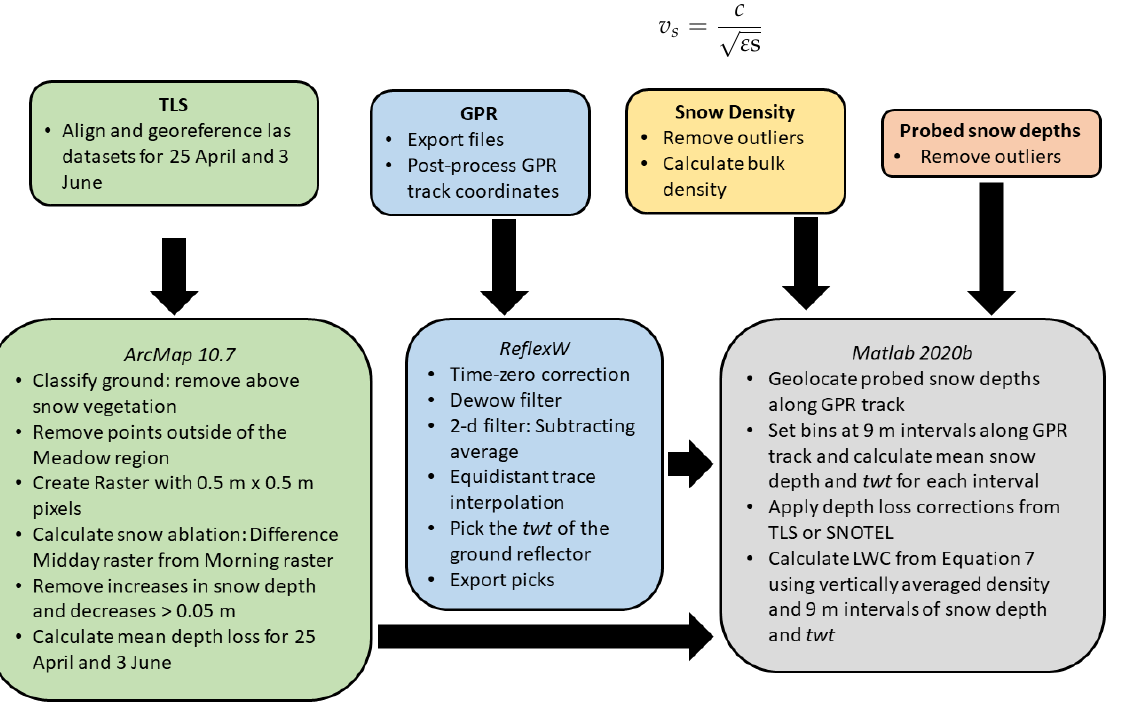
Figure 3. Schematic diagram of the methods for processing terrestrial laser scanning (TLS), GPR, and field measurements, and calculating LWC.